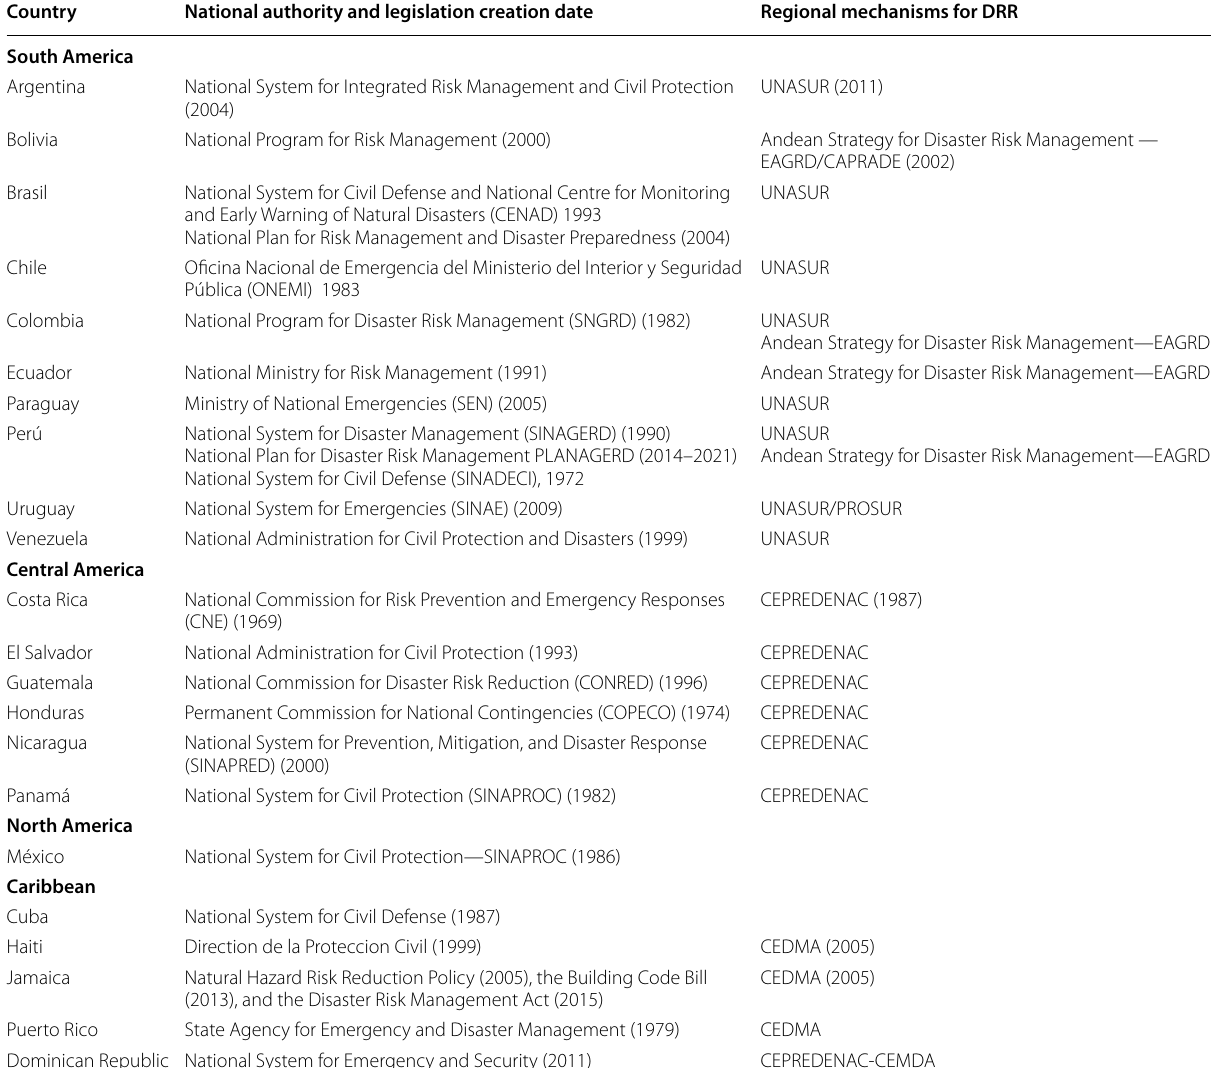
Table 1 Institutions for DRR in Latin-American countries (selection)